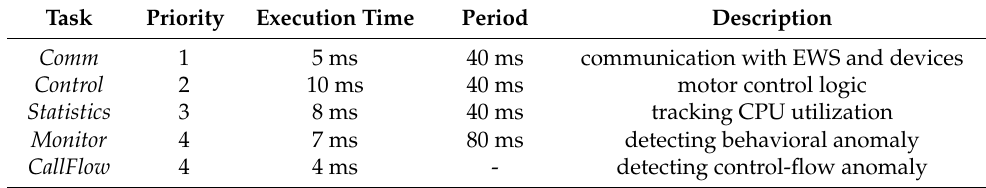
Table 2. Tasks in the